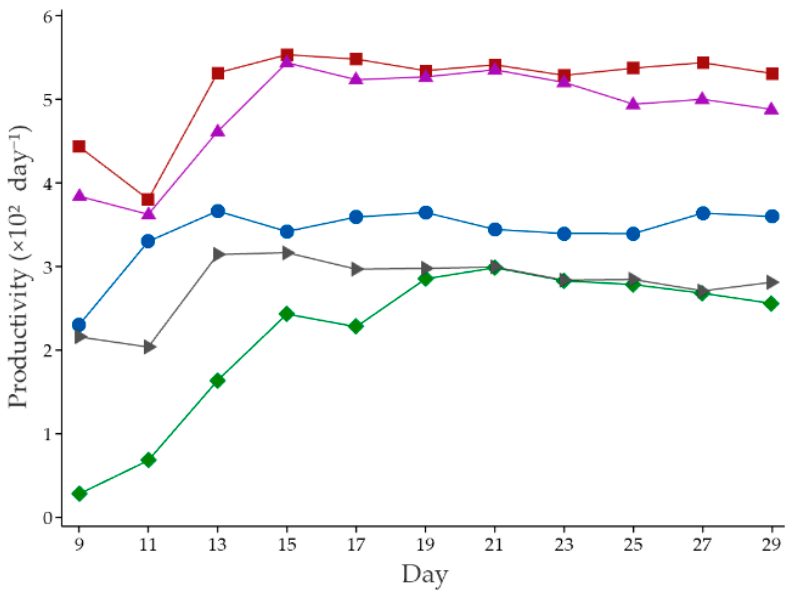
Figure 3. The productivity of gray oyster mushroom cultivated on cylindrical baglog (CB) with various treatments: ( • ) Control, ( (cid:4) ) M-LBS (1:1), ( (cid:7) ) M-LBS, ( (cid:78) ) D-LBS (1:1), and ( ) D-LBS within 30 days.